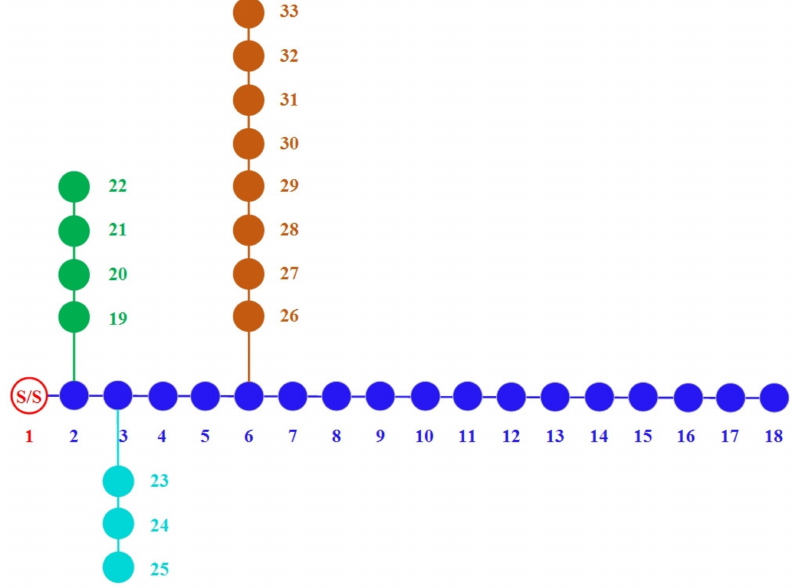
Figure 14. Standard IEEE 33-bus test